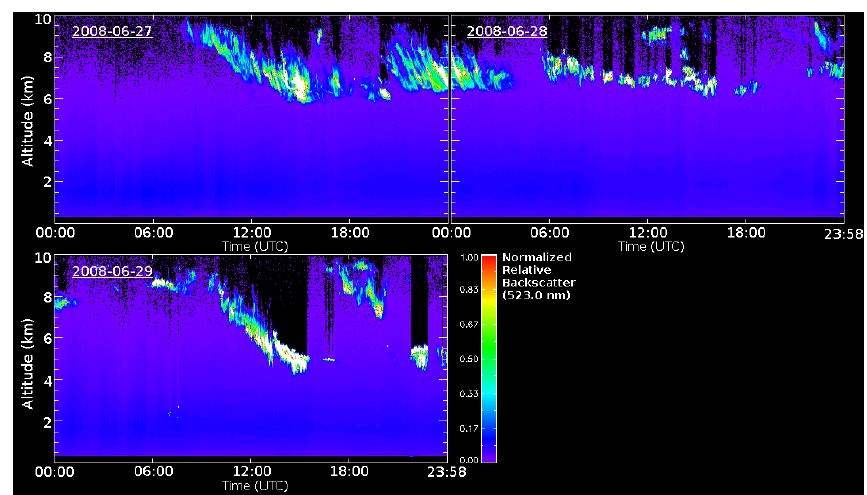
Figure 3. Normalized relative backscatter (Level 1.0 data) based on lidar measurements at Ny-Ålesund recorded during the period 27–29 June 2008 (modified from